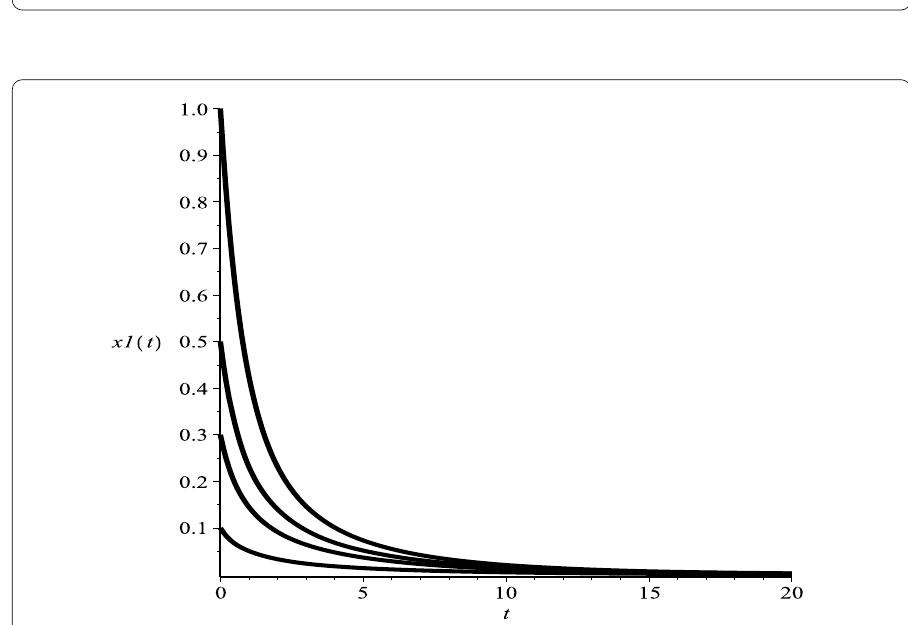
Figure 1 Dynamic behaviors of system (4.2), the initial conditions ( x 1 (0), x 2 (0)) = (0.5,2), (1,2), and (1,0.5), respectively